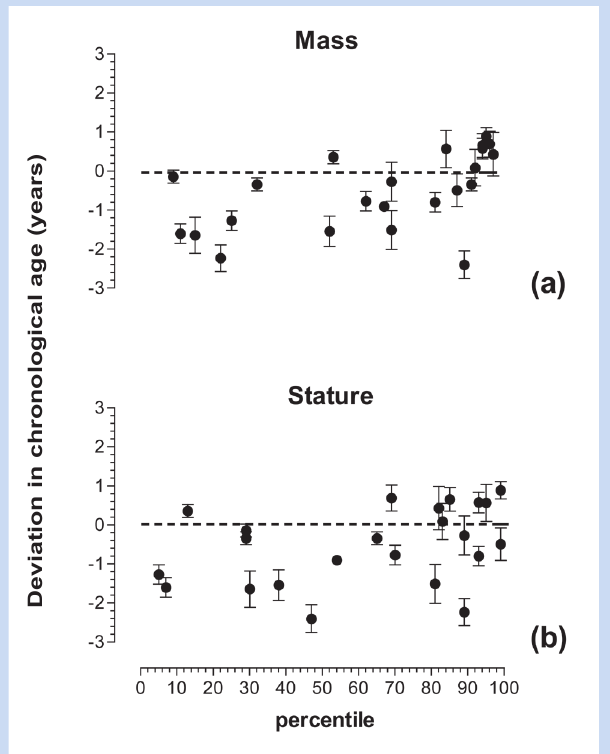
Fig. 1. Relationship between the deviations between chronological age and skeletal age and percentiles for body mass (a) and stature (b). A negative value means that chronological age has been underestimated by skeletal age. Each data point represents the mean difference for each subject ( N = 23) with the standard deviations for the predictions of the 9 radiologists.